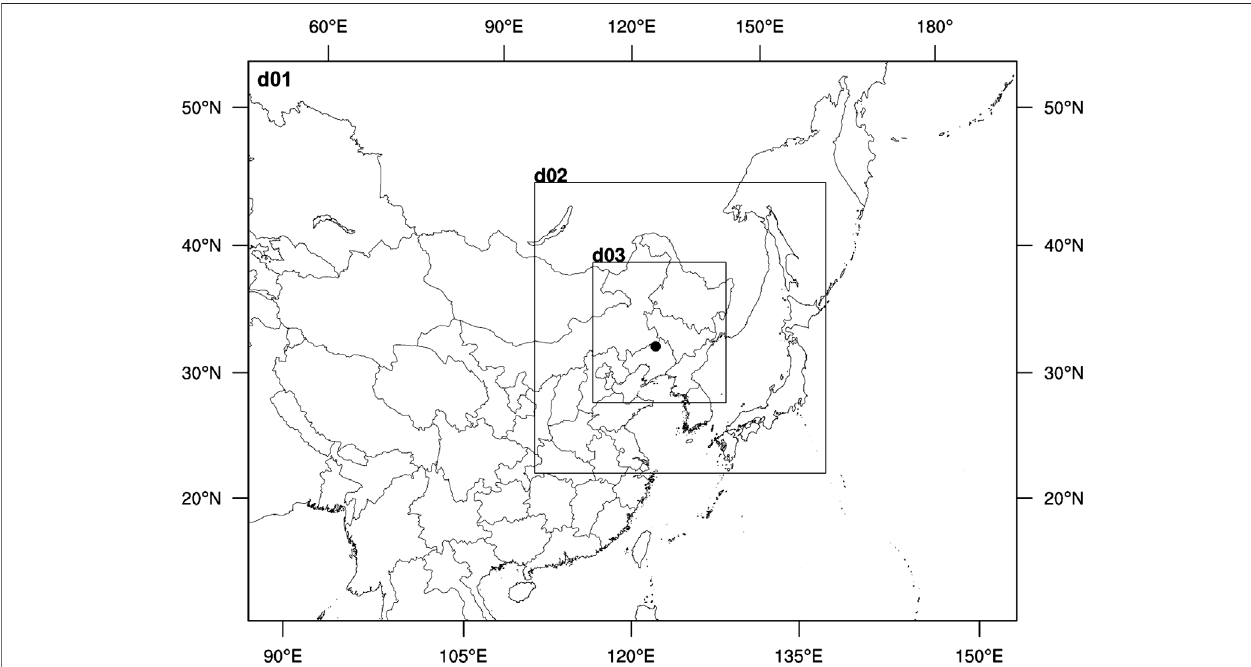
FIGURE 2 | Simulation domain in Lambert conformal projection (The black dot represents the location of the wind tower).